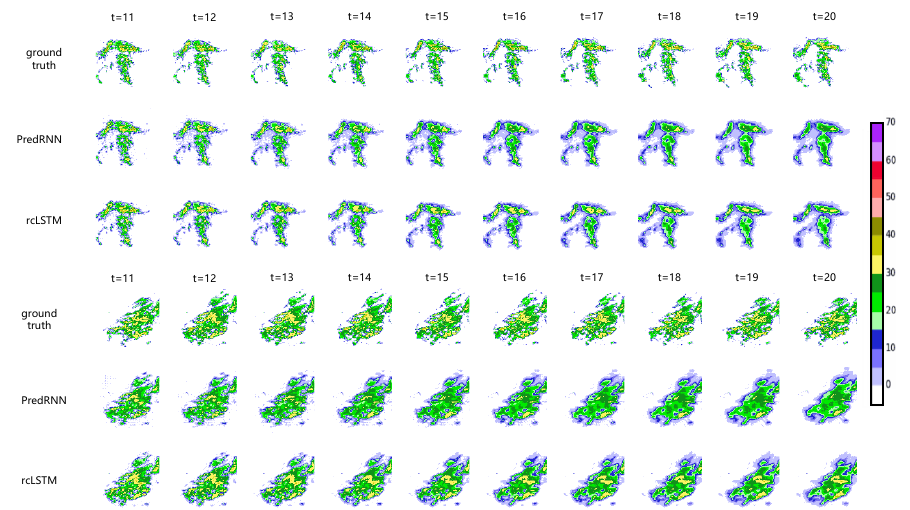
Figure 3. Examples of the next-hour predictions at 5:10 on 2 May 2017 and 15:16 on 22 May 2017 in Jiangsu, China. From top to bottom are the ground truth, PredRNN prediction result, and rcLSTM prediction result. The radar echo intensity is represented by different colors, in which blue represents 0–15 dbz, green represents 15–30 dbz, and yellow represents 30–40 dbz.